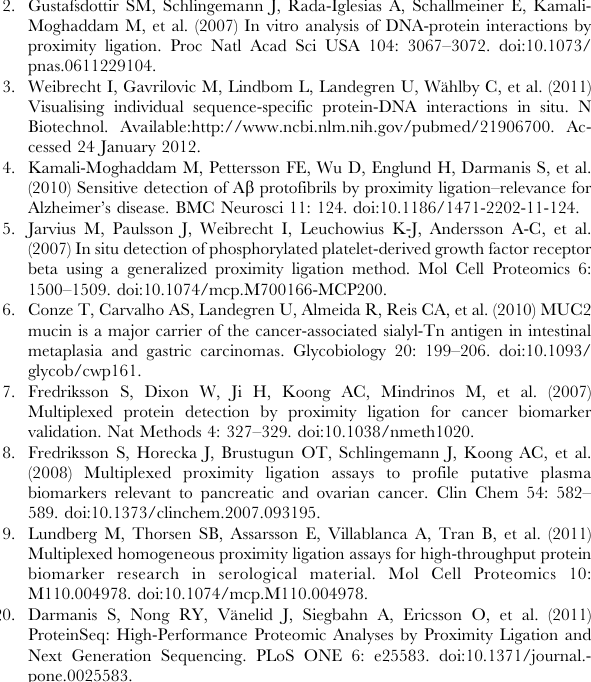
Figure S5 Validation of detection of protein-interaction between the NF k B-family proteins. The detection of protein interactions among the NF k B-family proteins was repeated with the two sample tag sequences, introduced during the ligation reaction, switched for the two samples. In this heat map negative log 2 Cy5/Cy3 ratios (green) indicate a greater abundance in sample I (transfected with p50, RelA and I k B a ), while positive log2 Cy5/Cy3 ratios (red) indicate a greater abundance in sample II (transfected with p50, RelB and I k B a ). Raw data are presented in Table S1b. Figure S6 Experimental setup for in situ PLA detection of Smad4 with fluorescent in situ detection and DTM readout. PLA probes directed to Smad4 and beta-actin were applied to slides with fixed cells that had or had not been transfected with Smad4. Connector oligonucleotides were added and joined into circular reporter molecules by enzymatic ligation. The reporter DNA circles were detected in situ in cells fixed on slides by allowing them to guide rolling circle amplification to generate large concatemers of DNA. The amplification products were then detected by hybridization with a fluorescence labeled detection oligonucleotide. For an alternative readout on micro- arrays, reporter DNA circles were released from slides by